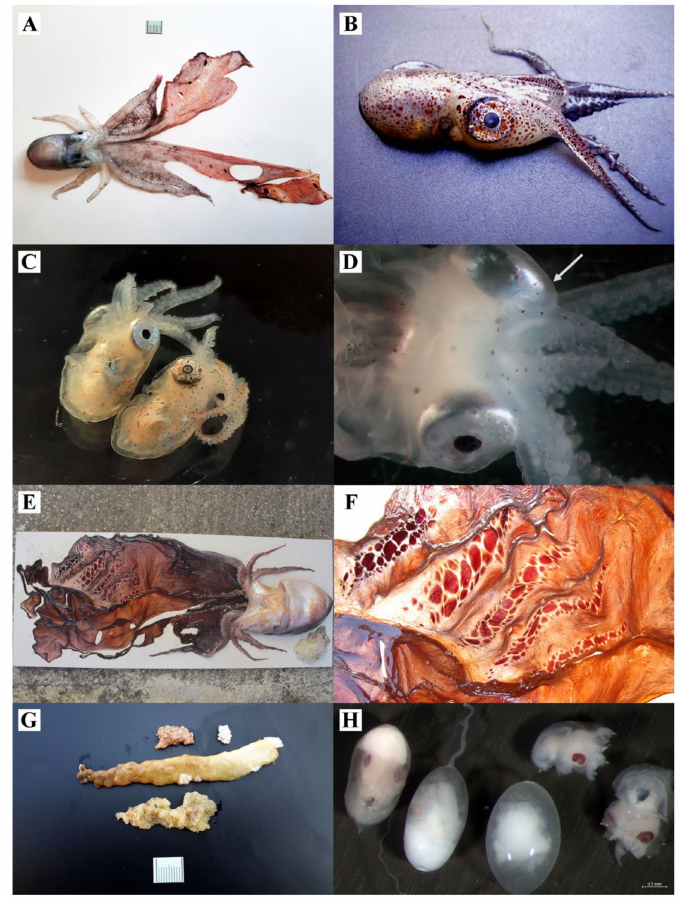
Figure 4. ( A ) Young female of Tremoctopus violaceus ; ( B ) Mature male of T. violaceus with the hecto- cotylus inside in a sac under the right eye; ( C ) Two immature males of Tremoctopus spp. stranded in 2021 in the Strait of Messina; ( D ) Particular of the hectocotylus of an immature male of Tremoctopus spp. (the same individual photographed in Figure 4C, on the left) in a developing status within the sac under the right eye (ventral view, grey arrow). ( E ) Ventral view of a large mature female of Tremoctopus gracilis ; ( F ) Web of dorsal arms of T. gracilis and chromatophore pattern typical of the species.; ( G ) Fertilized eggs of T. gracilis at different maturity stages and rod (centre) to which the egg mass is usually attached; ( H ) Fertilized eggs at different stages of development and embryos observed with a